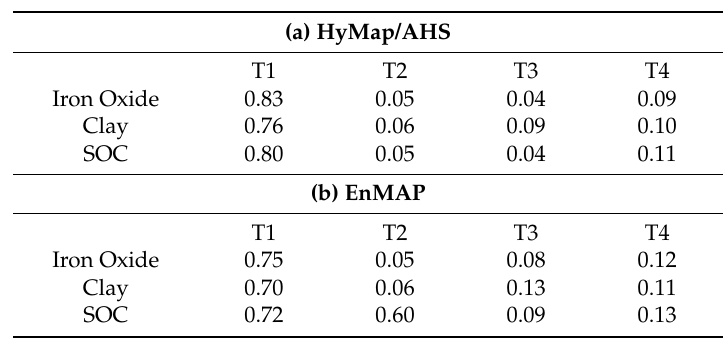
Table 4. Values of uncertainty expressions for ( a ) airborne HyMap/AHS imagery; and ( b ) simulated EnMAP images. The values are relative (in %) to the total variance. The terms are: T1 the hyperspectral data uncertainty, T2 the model coefficients uncertainty, T3 the laboratory reference measurement uncertainty, and T4 the dependency between the spectral and model uncertainties (mixture